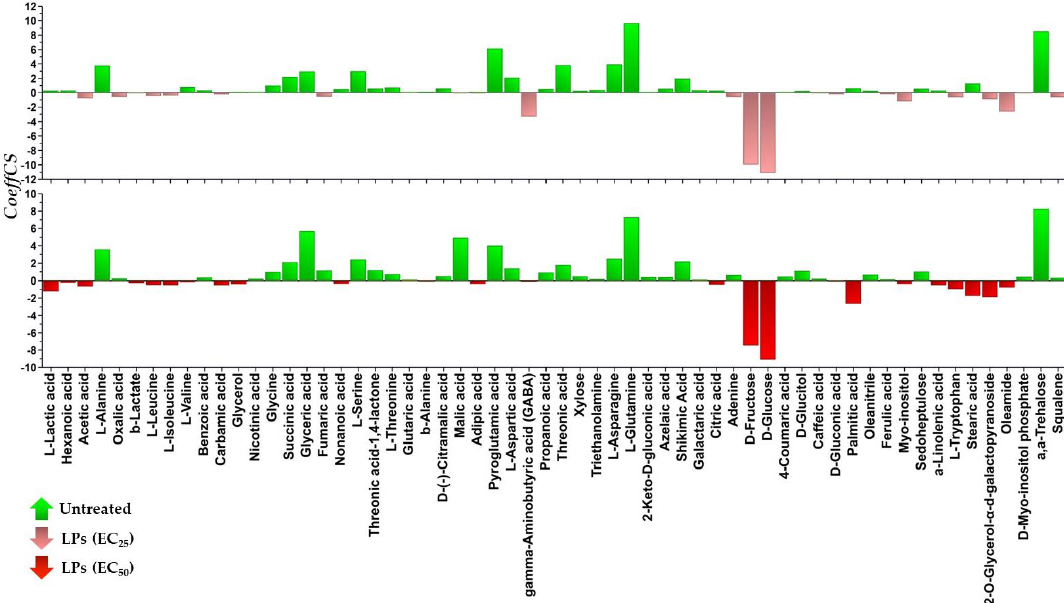
Figure 5. Coefficient plots displaying metabolite differences between the untreated and EC 25 (156 µ g · mL − 1 ) ( Upper plot ) or EC 50 (419 µ g · mL − 1 ) lipopeptide-treated ( Lower plot ) Lemna minor L. plants. Values of scaled and centered OPLS regression coefficients (CoeffCS) are displayed. High absolute values of CoeffCS correspond to annotated metabolites with the highest leverage on the observed discrimination. Positive values correspond to metabolites with increased levels in the untreated, whereas negative to those with increased levels in the lipopeptide-treated plants. Toxics 2022 , 10 , x FOR PEER REVIEW